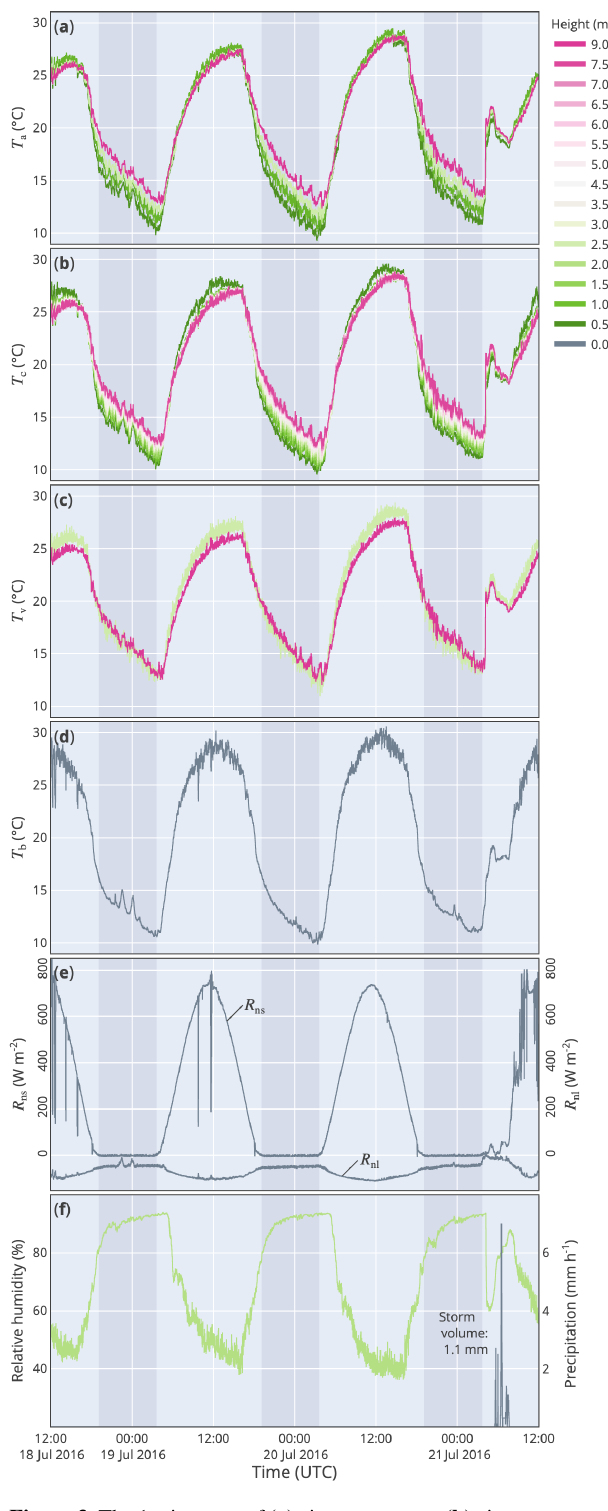
Figure 4. The 30min mean height profile of (a) wind direction, (b) wind speed, and for 3m height the (c) the stability length pa- rameter, (d) the friction velocity, (e) latent heat ( LE ) and sensible heat ( H ) flux, (f) quality and stability classification, and (g) stability against height. See text for